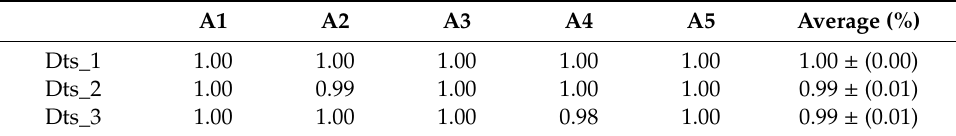
Table 9. Cross validation accuracies calculations. A1 A2